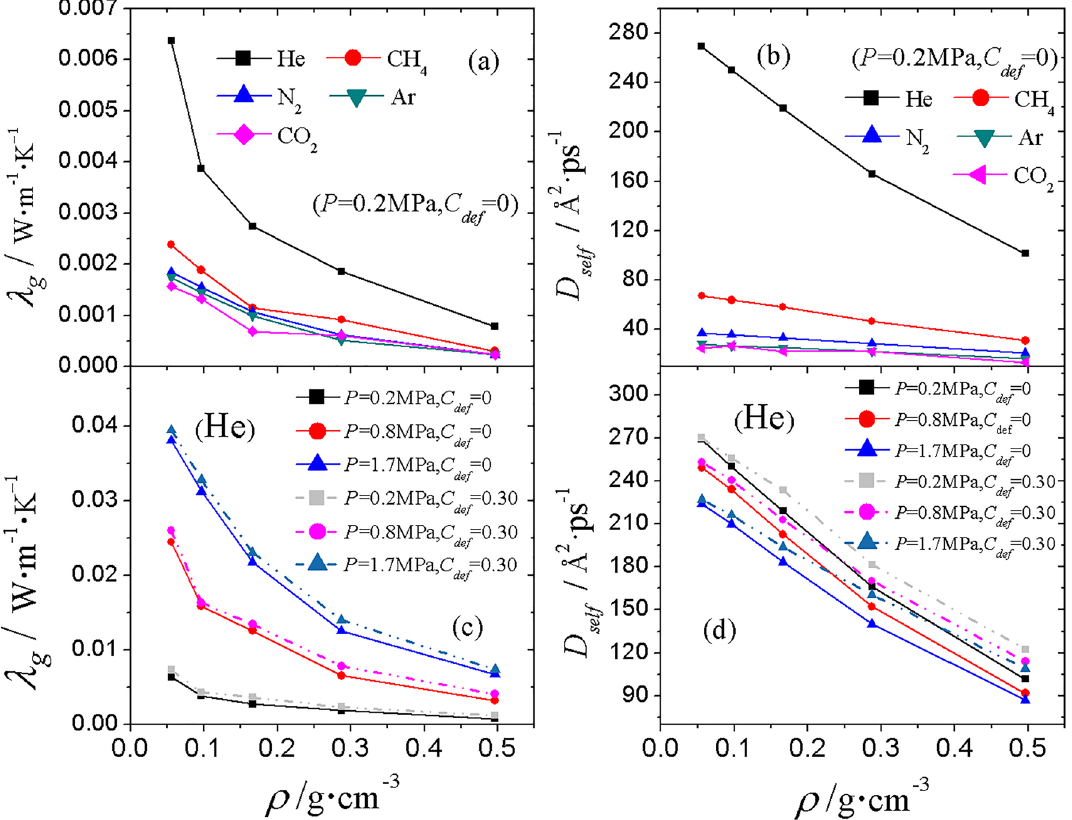
Figure 6. The gas conductivity (cid:31) g for ( a ) different gas species and under ( c ) different pressures and defect concentrations C def . Self-diffusion coefficient D self of gas molecules for ( b ) different gas species and under ( d ) different pressures and defect concentrations C def . For clarity, the results for perfect ( C def = 0) and defective structures were aligned to the same ρ which is the density of the original skeleton before deleting